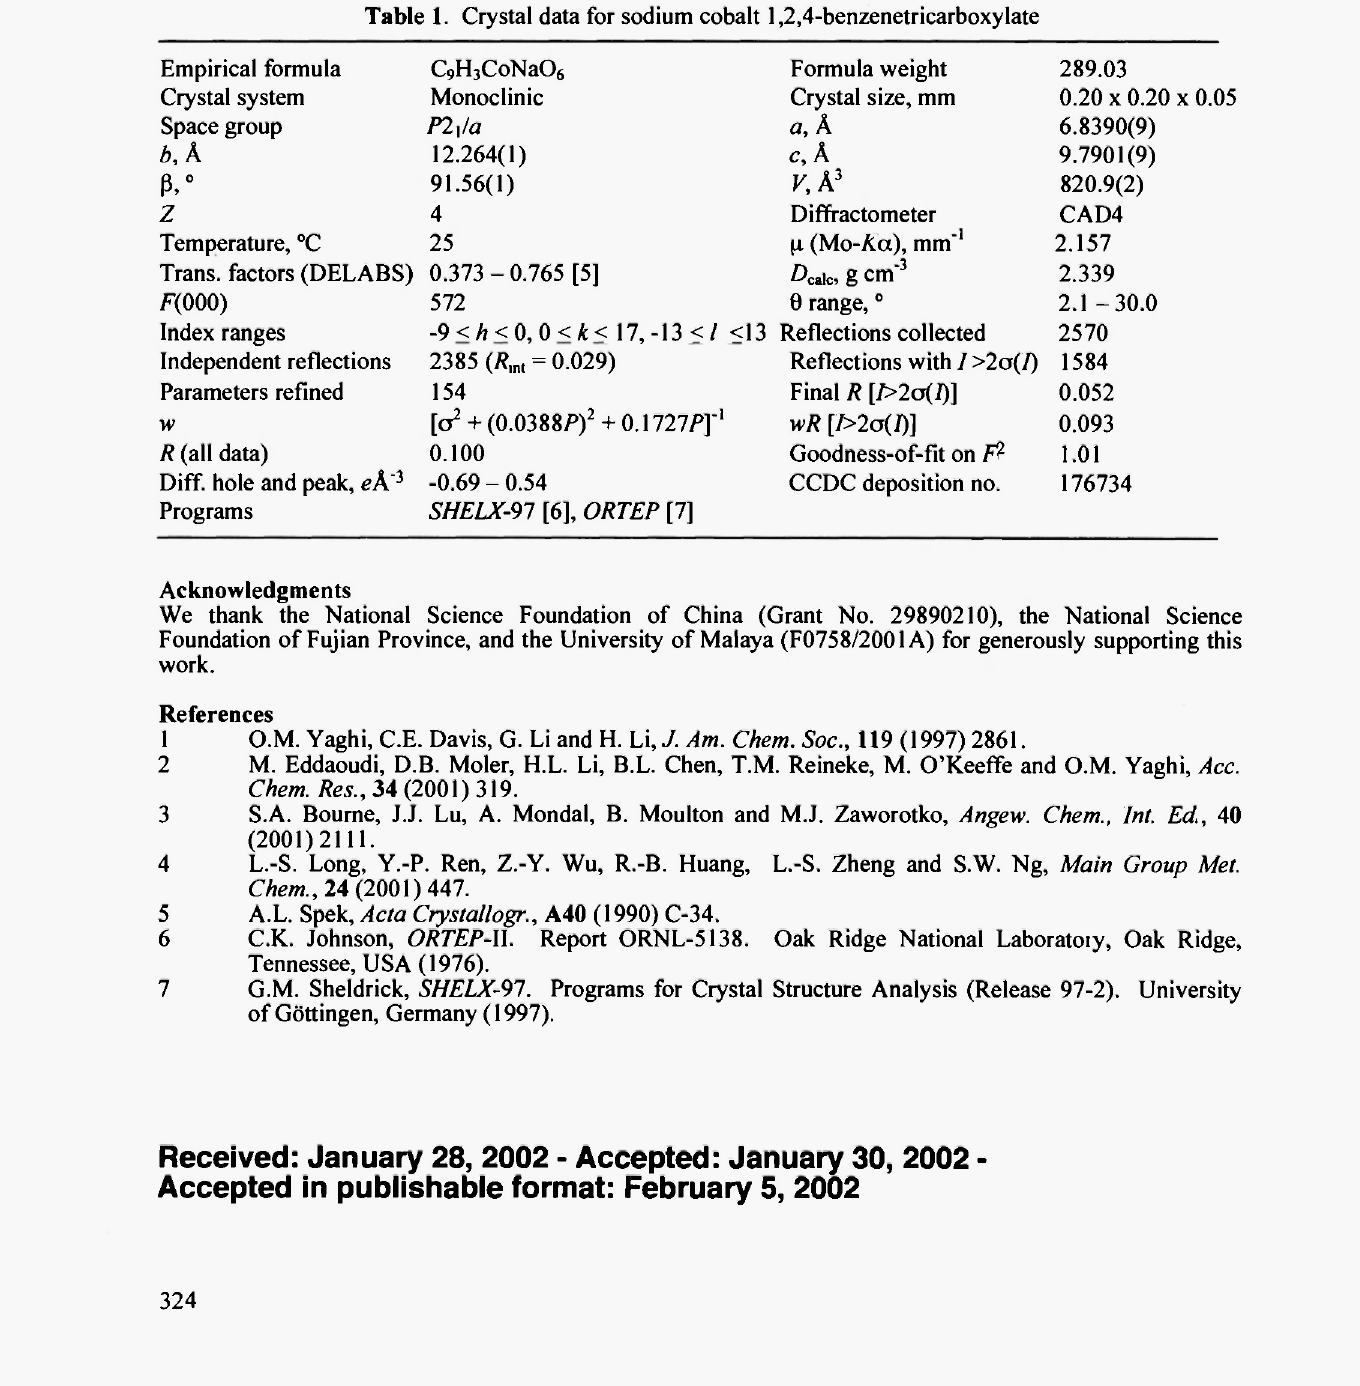
Table 1. Crystal data for sodium cobalt